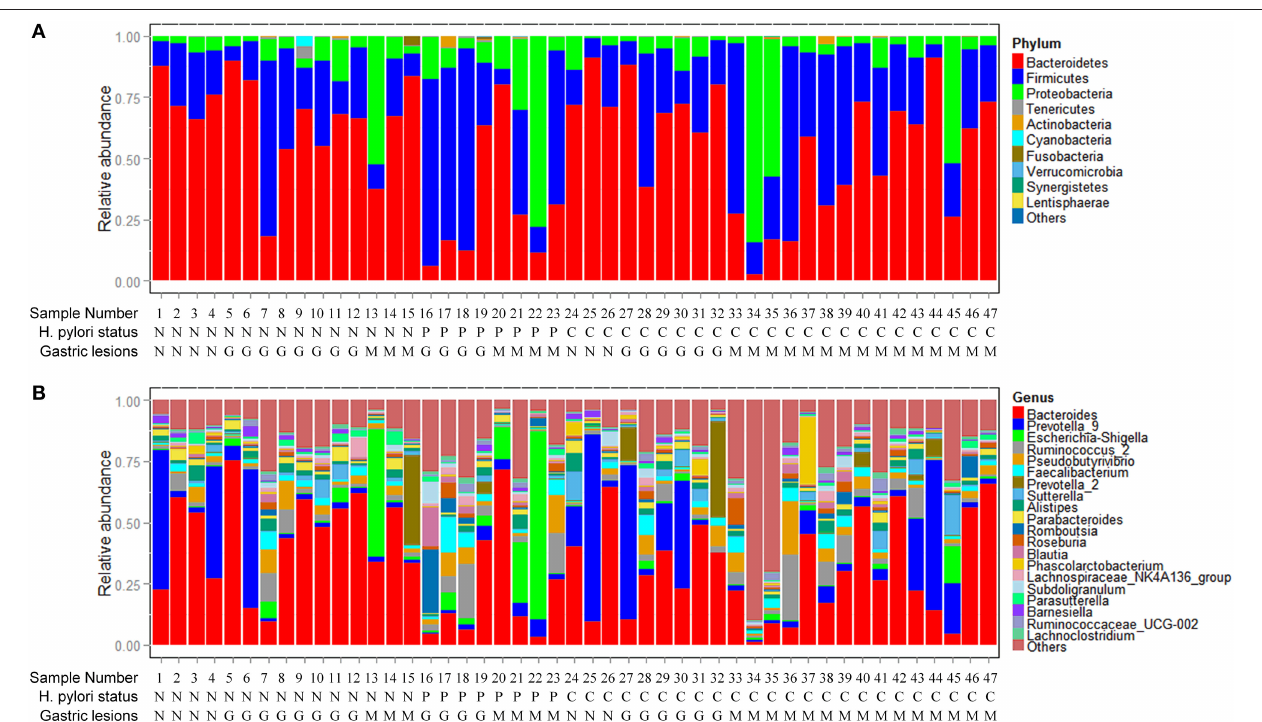
FIGURE 1 | Composition of fecal microbiota. (A) Relative abundance distribution of major phyla (top 10) in 47 fecal samples. Phyla were sorted by decreasing order of average relative abundance. H. pylori status and gastric lesions observed for each subject are listed below. (B) Relative abundance distribution of major genera (top 20) in 47 fecal samples. Genera were sorted by decreasing order of average relative abundance as in (A) . H. pylori status: N, H. pylori negative; P, past H. pylori infection; C, current H. pylori infection. Gastric lesions: N, normal; G, gastritis; M,